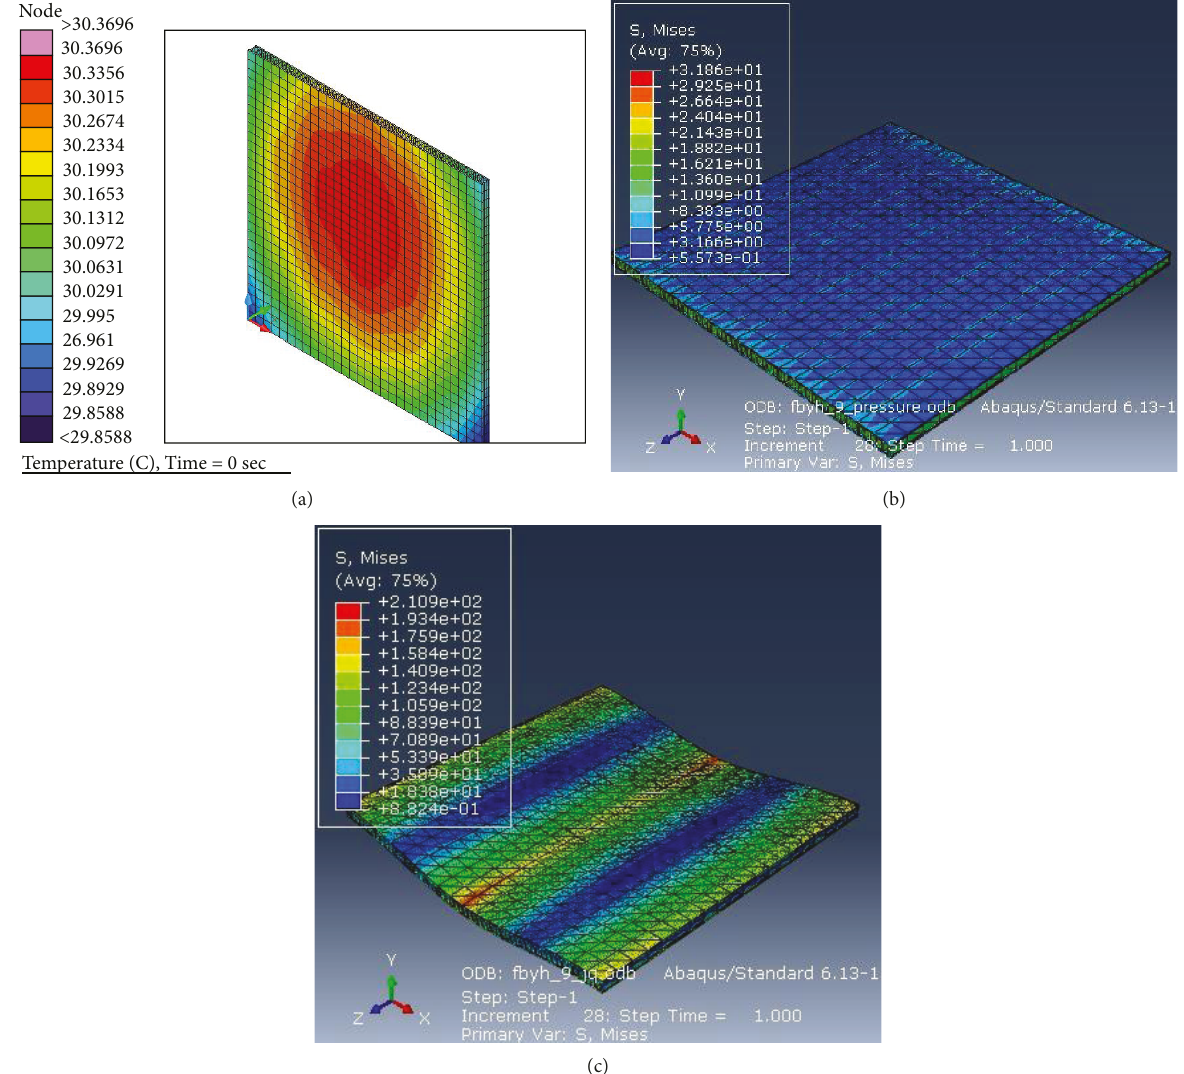
Figure 10: Performance analysis of the new type of solar panel after optimization (a) temperature di ff erence, (b) compression strength, and (c) shear